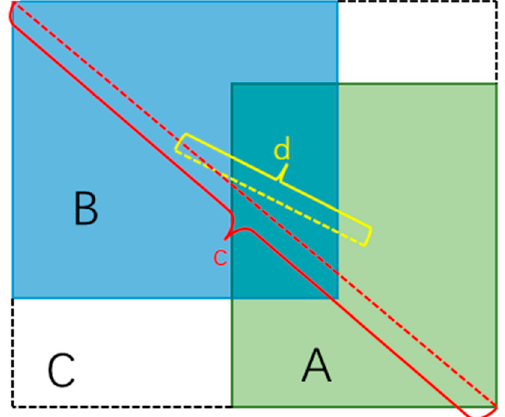
Figure 2. Schematic diagram of DIOU (A and B represent two ship candidate boxes, C is the smallest box containing A and B, c represents the diagonal distance of C, d represents the distance between the center points of two candidate boxes).